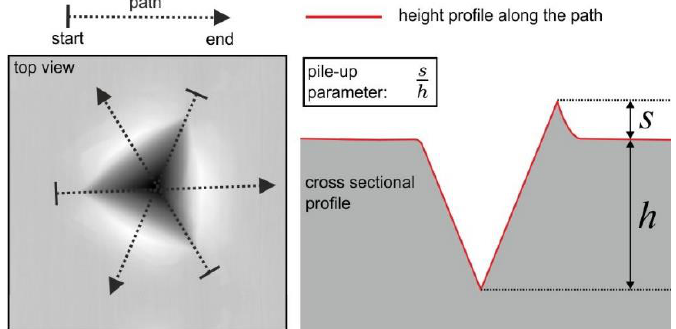
Figure 3. Schematic illustration of a residual indentation imprint and the three paths used to extract height profiles to determine the normalized pile-up parameter s/h . The average of the height profiles along the three illustrated paths was calculated for each indent.